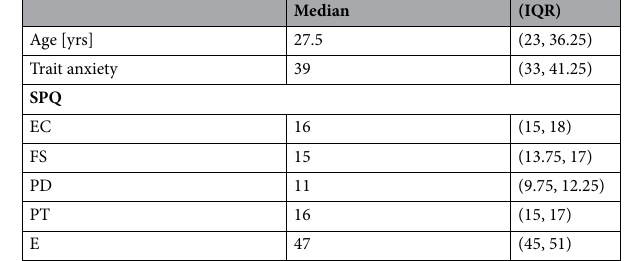
Table 1. Participants’ age, trait anxiety and trait empathy as determined by SPQ (n = 46). SPQ Saarbrucken Personality Questionnaire, EC empathic concern, FS fantasy, PD personal distress, PT perspective taking, E empathy score (= EC + FS +